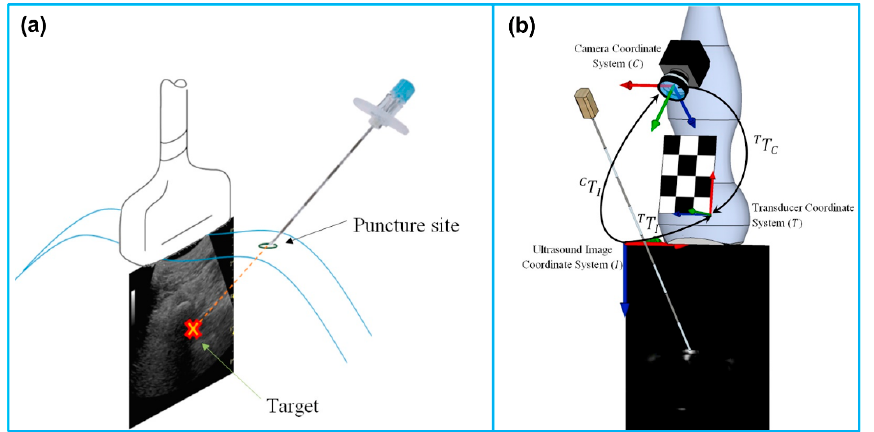
Figure 12. A magnetic navigation system for liver cancer ablation procedures. ( a ) The setup of the magnetic navigation system; ( b ) Magnetic field generator and magnetic receivers attached to an US probe. Reprinted from [162] with permission.